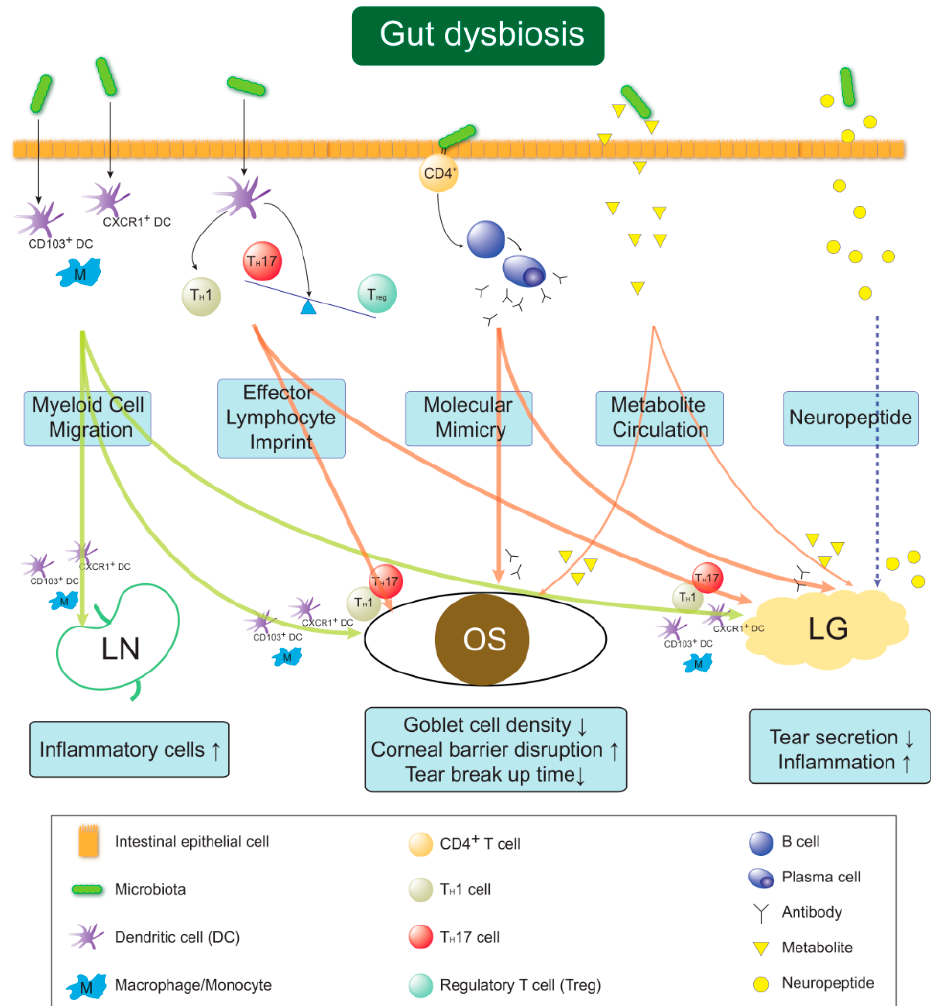
Figure 3. The hypothesis of Gut dysbiosis–Ocular surface–Lacrimal gland Axis. Gut dysbiosis may induce dry eye disease by the following five mechanisms. Myeloid cell migration theory; Gut dysbiosis-mediated CD103 + or CXCR1 + dendritic cells or monocyte/macrophages migrate to drainage lymph nodes, ocular surface and lacrimal glands in order to prime T cells or secrete pro-inflammatory cytokines. Effector lymphocyte imprint theory; Gut-derived helper T 1 (T H 1) and 17 (T H 17) cells migrate to the ocular surface and lacrimal gland, or gut-derived T reg cells are less circulated. Molecular mimicry theory; Microbial-derived antigens cross-prime autoreactive CD4 + T cells helping B cells to produce autoantibodies. Metabolite circulation theory; Microbial metabolites, such as short-chain fatty acids, decrease to enter systemic circulation reaching ocular surface and lacrimal gland. Neuropeptide circulation theory; Homeostatic circulation of gut-derived neuropeptides is distributed to reach lacrimal gland and influence tear secretion.